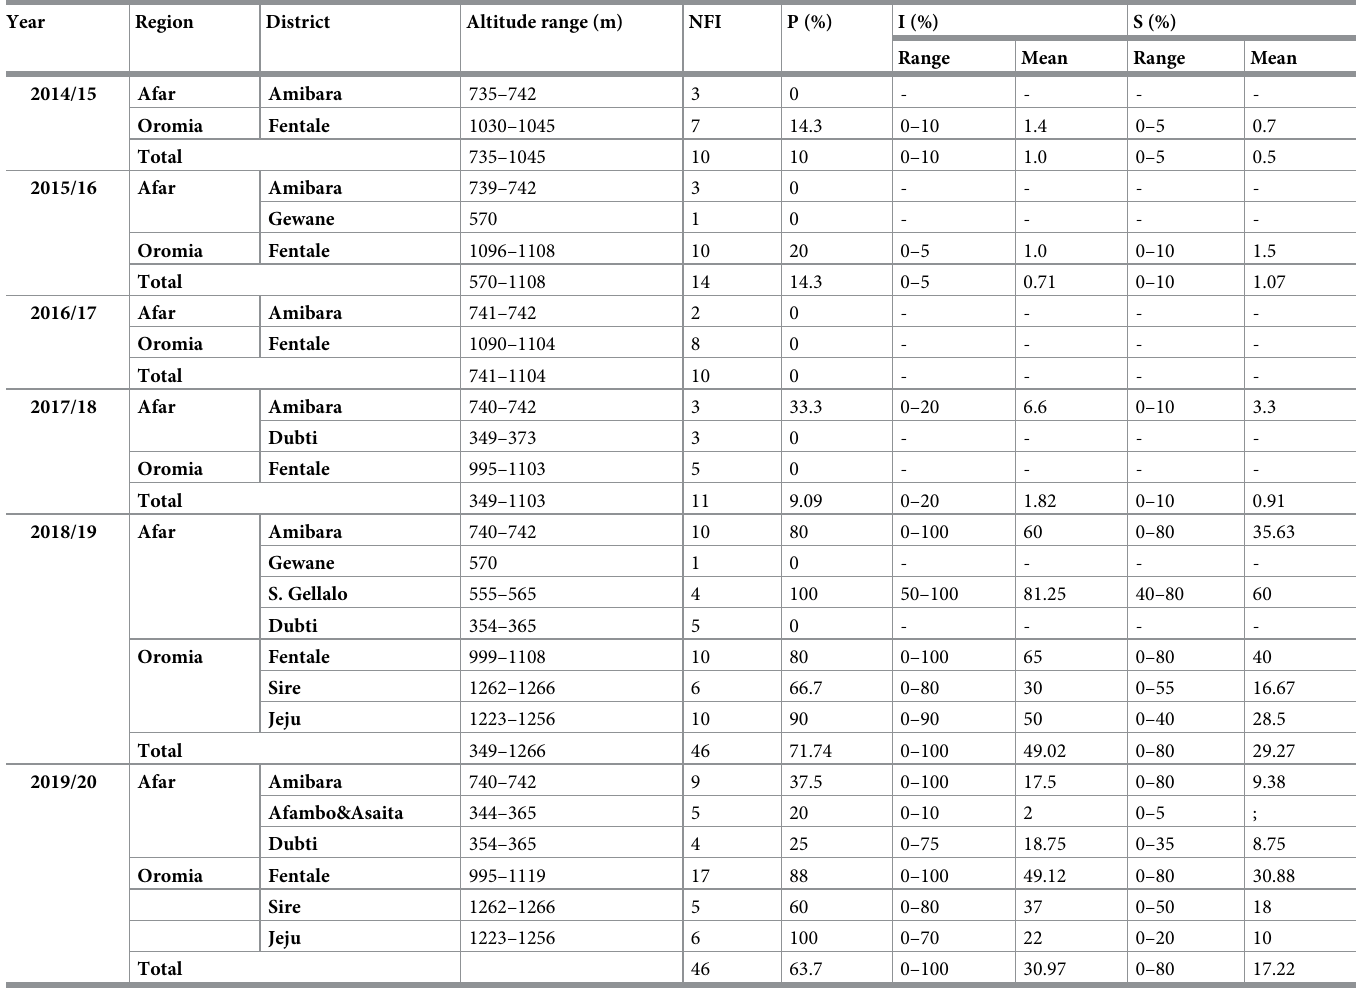
Table 3. Prevalence, incidence, and severity of Pgt in the districts of Awash River Basin in 2014/15-2019/20 production